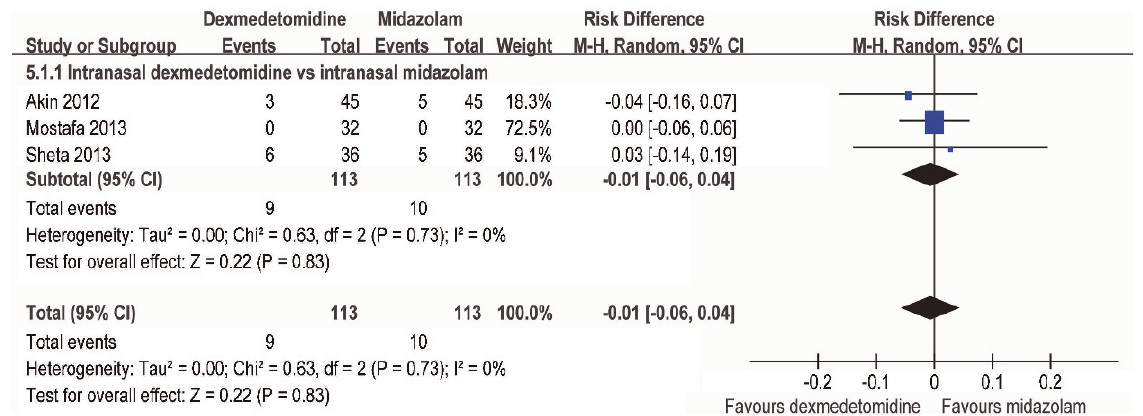
Figure 6 - Meta-analysis of PONV in children treated with dexmedetomidine vs . midazolam. PONV: postoperative nausea and